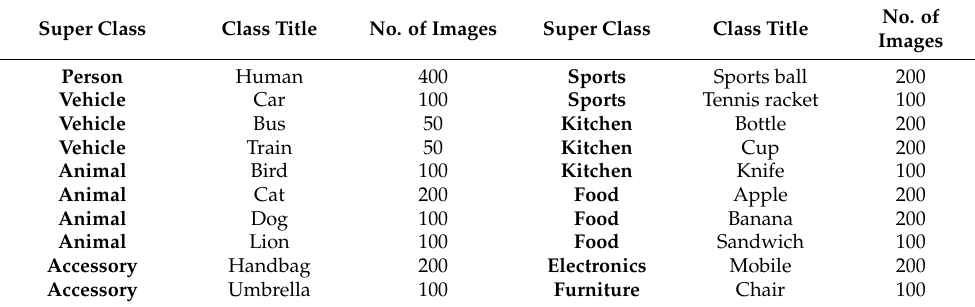
Figure 6. ( a ) This figure shows the bottom-up (feature-based) attention-based recognition of an object such as a cat with 89% accuracy, and the attention level is high. ( b ) This figure shows the